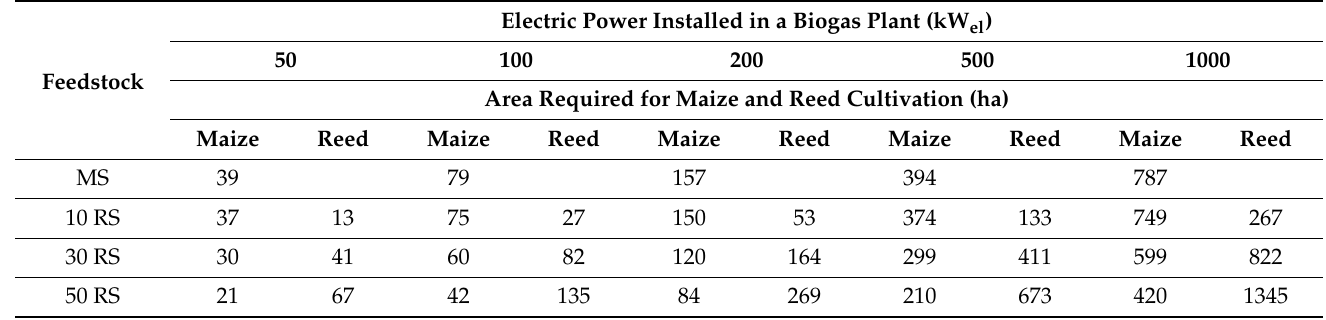
Table 6. The area required for the cultivation of maize and reed depending on the studied maize and reed silage combinations and the electric power installed in the biogas plant.